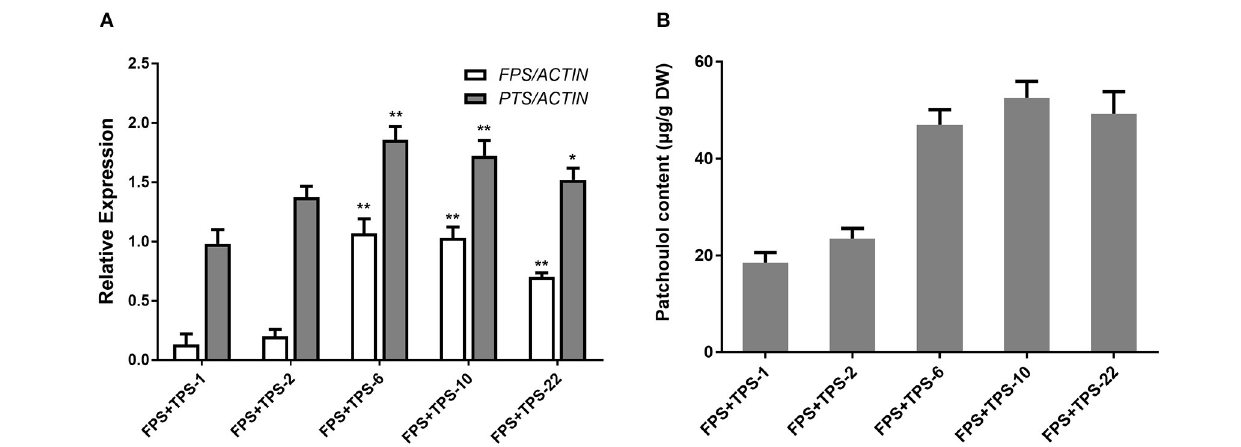
FIGURE 2 | Engineering patchoulol biosynthesis in the cytoplasm of A. annua leaves. (A) Relative expression of FPS and PTS in FPS + PTS transgenic A. annua lines. (B) The patchoulol content in FPS + PTS transgenic A. annua lines. ACTIN was used as internal control. T0 transgenic lines were used for analysis. The error bars represent the means ± SD from three biological replicates. All data represent the means ± SD of three replicates. ** P < 0.05, * P < 0.01, student’s t -test.